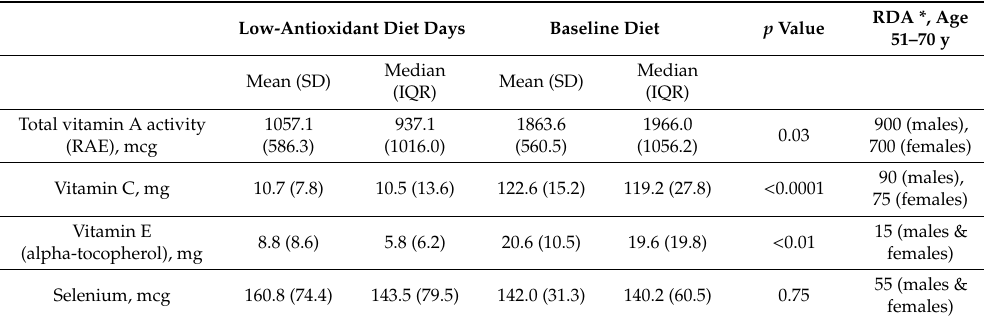
Table 3. Antioxidant nutrient intakes of participants during low-antioxidant diet and